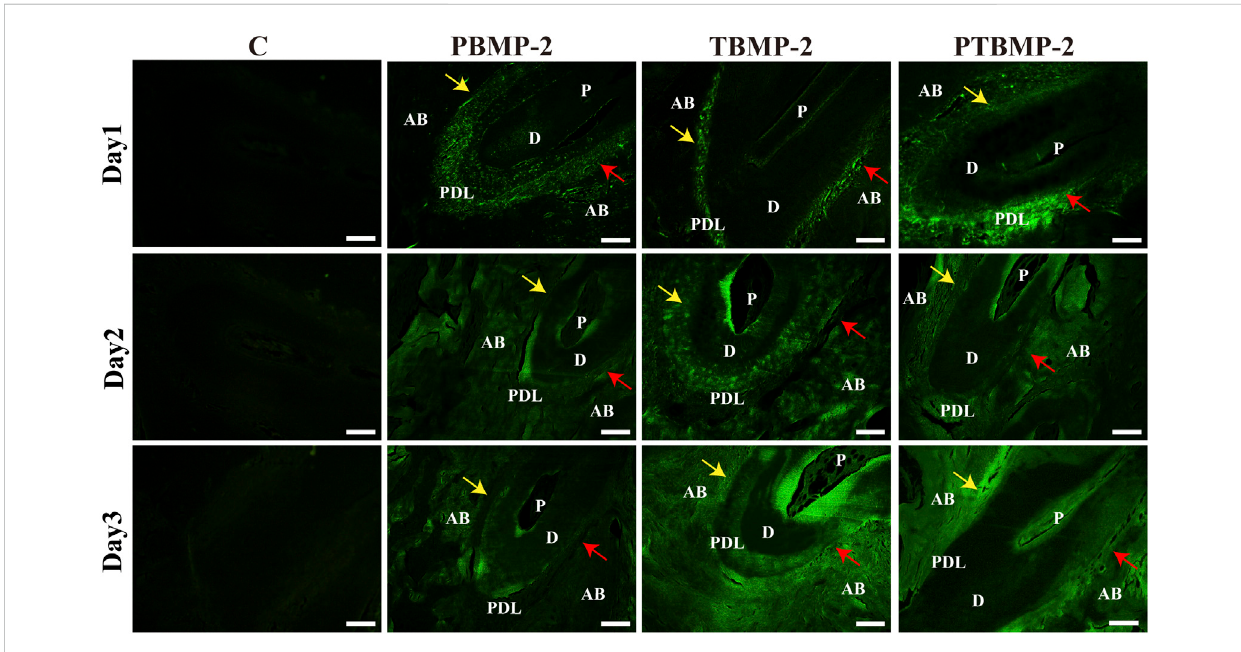
FIGURE 3 Distribution of exogenous BMP-2 inperiodontal tissues of orthodontictooth. The fl uorescently labeledBMP-2appeared green in color. Scale bar = 200 μ m. AB, alveolar bone; D, dentin; PDL, periodontal ligament; P, dental pulp. Yellow arrows, pressure side of the root. Red arrows, tension side of the